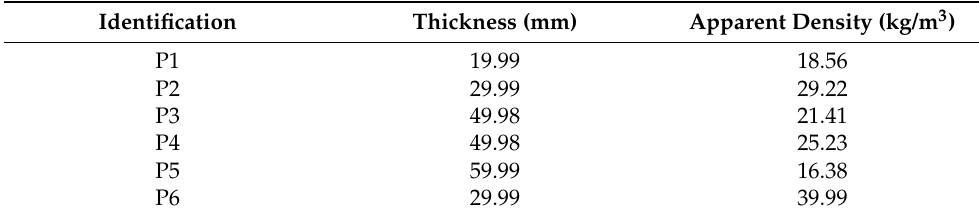
Table 1. Thermal-insulation mattresses produced using textile waste, recycled PET waste and natural fibres of plant and animal